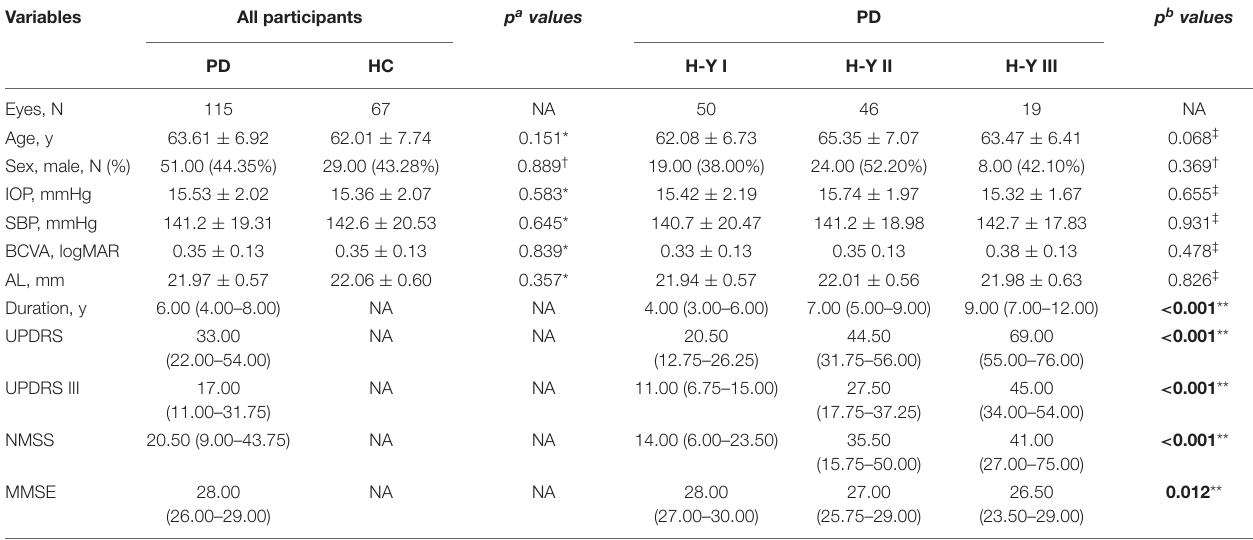
TABLE 1 | Demographic characteristics of all enrolled